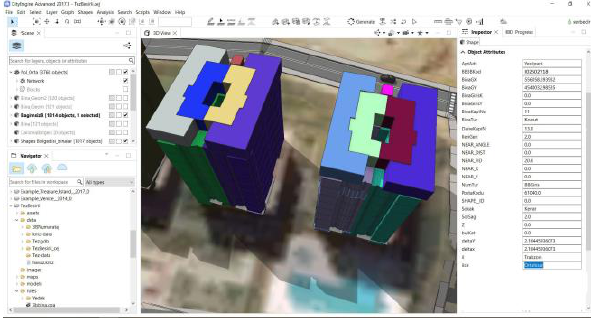
Figure 5. Separately colored independent section 3D models of buildings with address